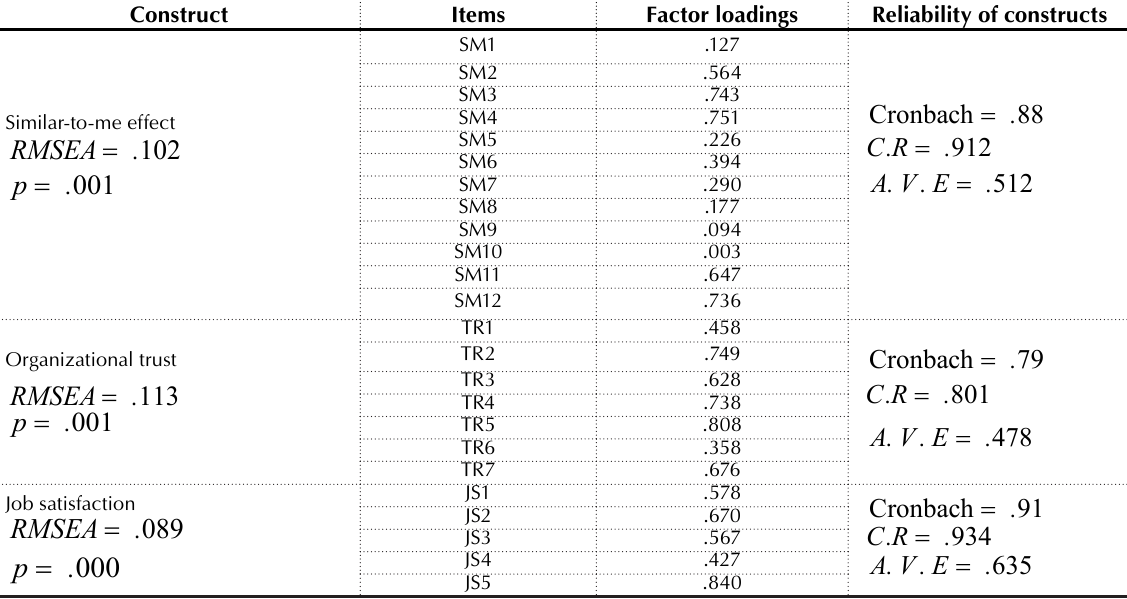
Table 1. Overall reliability of the constructs and factor loadings of